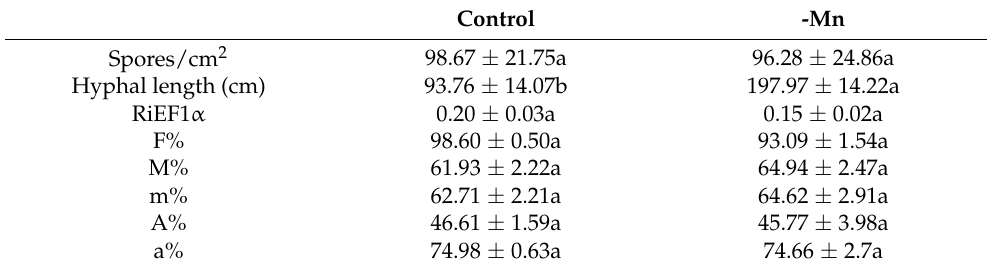
Table 1. Effect of Mn deficiency on ERM development and mycorrhizal colonization.